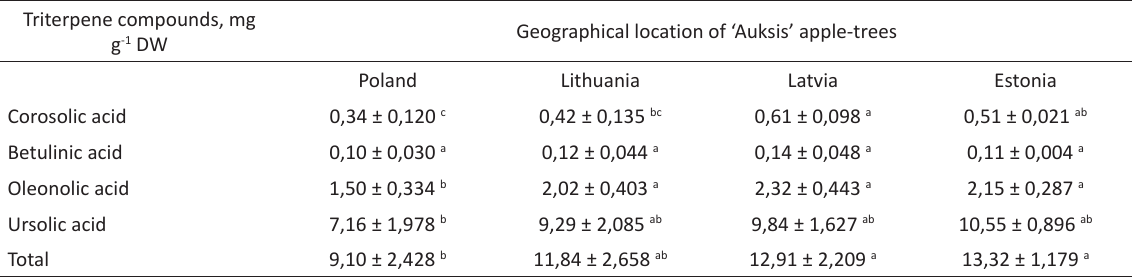
The different letters on the same line indicate statistically significant differences between the individual compounds in the apple samples ( p < 0.05). Table 4. Amount of investigated triterpene compounds (mg g -1 DW) in apple peel grown in different geographical locations (cv. ‘Ligol’, average 2016–2018) Triterpene compounds, mg g -1